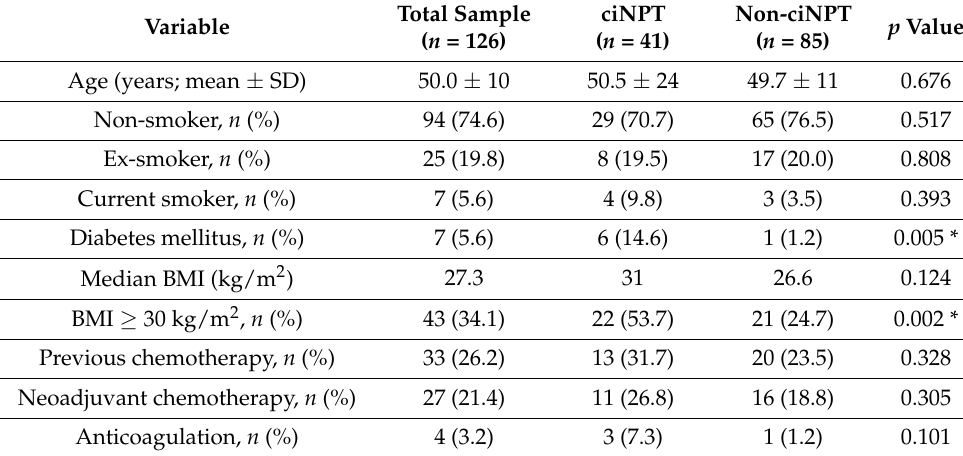
Table 1. Preoperative characteristics of ciNPT (Prevena) vs. non-ciNPT (Comfeel) groups.